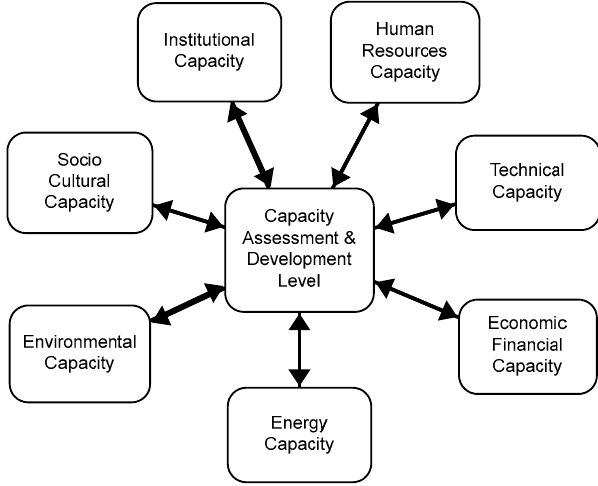
Figure 4. The modular structure of the stock-and-flow diagram.